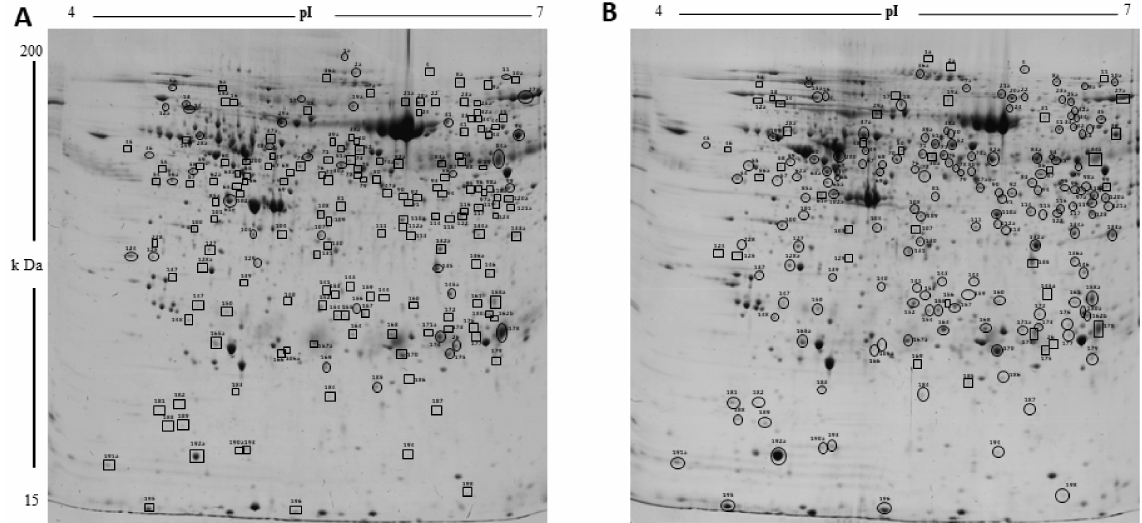
Figure 1. The two-dimensional gel electrophoresis analysis of corpus luteum proteins. Representative 2DE gel image of differentially abundant protein spots in corpus luteum on ( A ) Day 3 and ( B ) Day 9 of the estrous cycle. There were 191 spots that changed significantly ( p < 0.05) between two the groups, and are shown in the map and indicated by numbers. Circles and squares designate spots with increase and decrease in abundances, respectively on a day of estrous cycle. Proteins corresponding to spot numbers are listed in Table